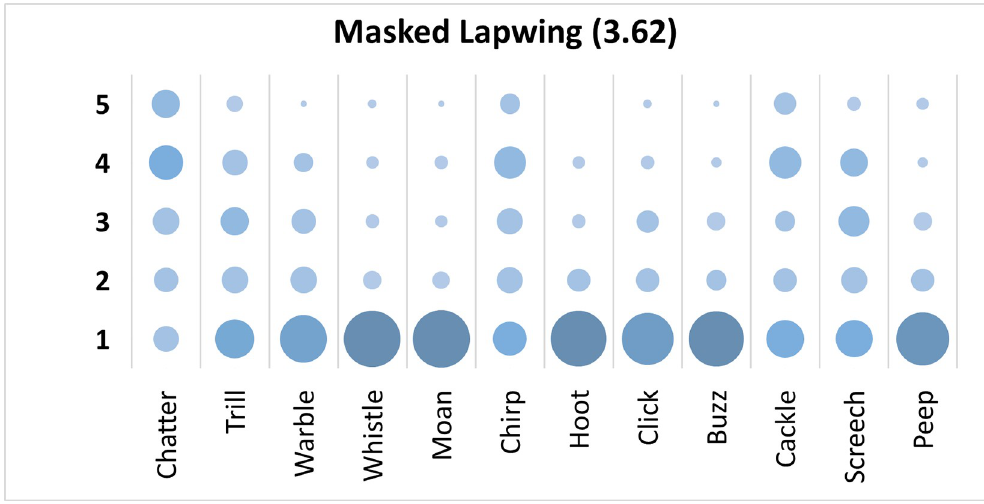
Fig 4. Count of participants’ sound descriptions scores for the Masked Lapwing with confidence ratings in